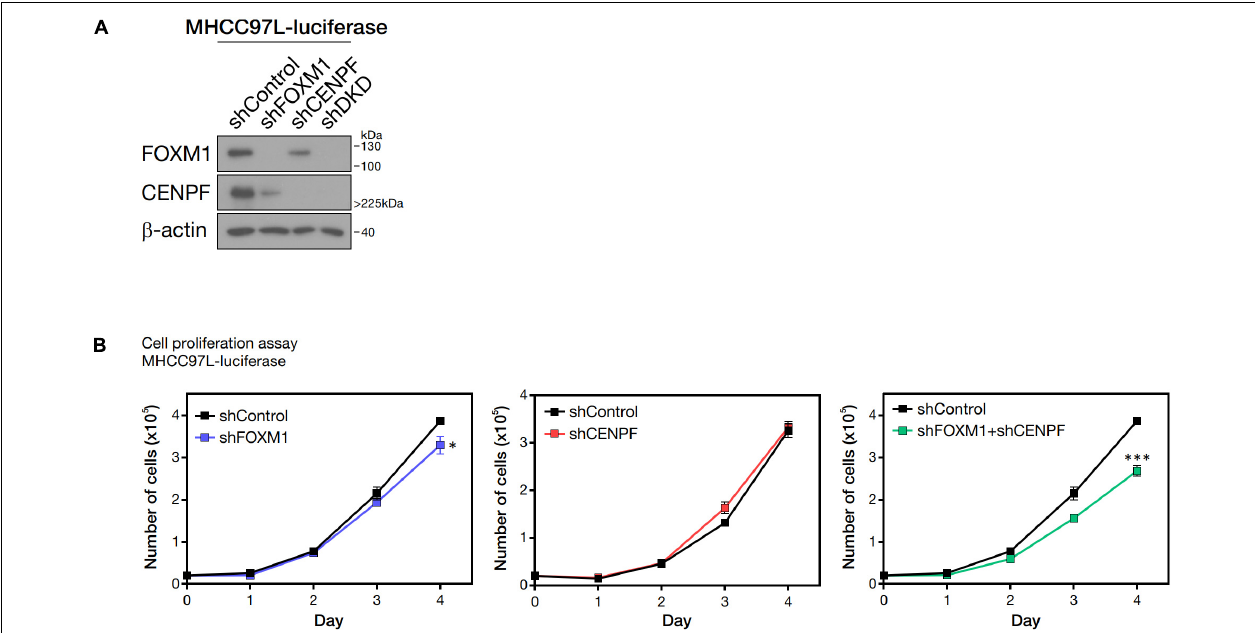
FIGURE 2 | Pro-proliferative role of FOXM1 and CENPF. (A) Western blot analysis showing single and double knockdown efficiencies of FOXM1 and CENPF in MHCC97L-Luc cells. (B) Representative cell proliferation assay showing the growth curves of HCC cells with single and co-knockdown of FOXM1 and CENPF